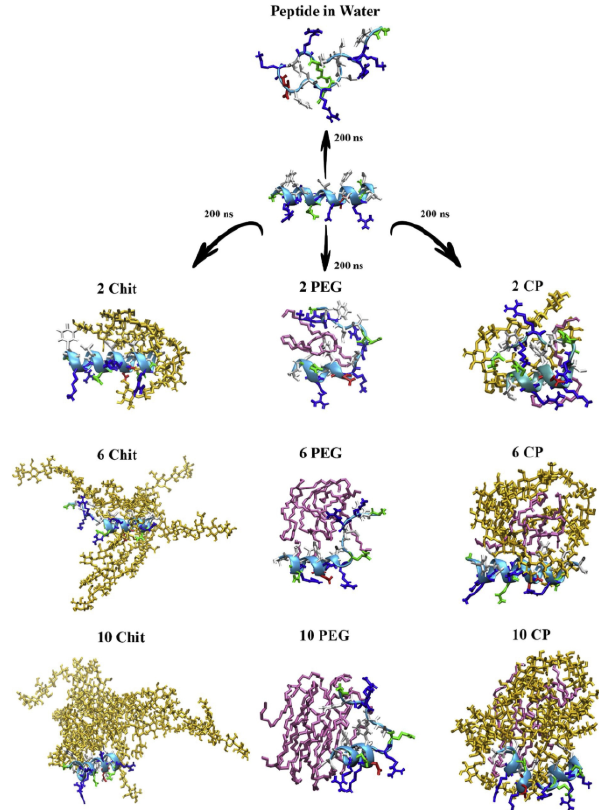
Figure 3. Snapshots of antimicrobial peptide GF-17 interacting with chitosan (left), PEG (middle), and both chitosan and PEG (right) (reprinted with permission from [84] . Copyright (2020) Elsevier).